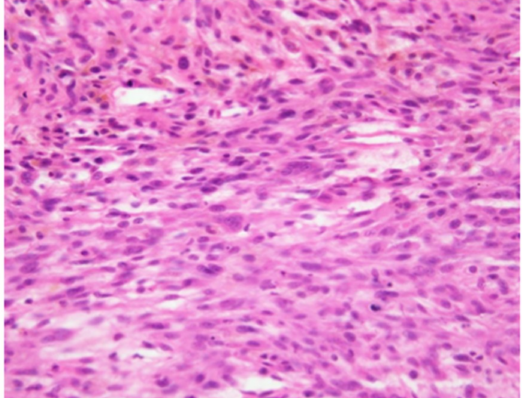
Figure 2. Histological image of the biopsy specimen (H.E. stain, 40 × ). Spindle cells with atypical nuclei proliferated with giant multinucleated giant cells. The MIB-1 index was 25% and the number of mitotic cells was about 20 cells per 10 × area. According to the immunohistochemistry analysis, AE1/3, EMA, S100, myogenin, desmin, D2-40, CD31, and CD34 were negative and the tumor cells were not specifically differentiated. Thus, the patient was diagnosed with undifferentiated pleomorphic